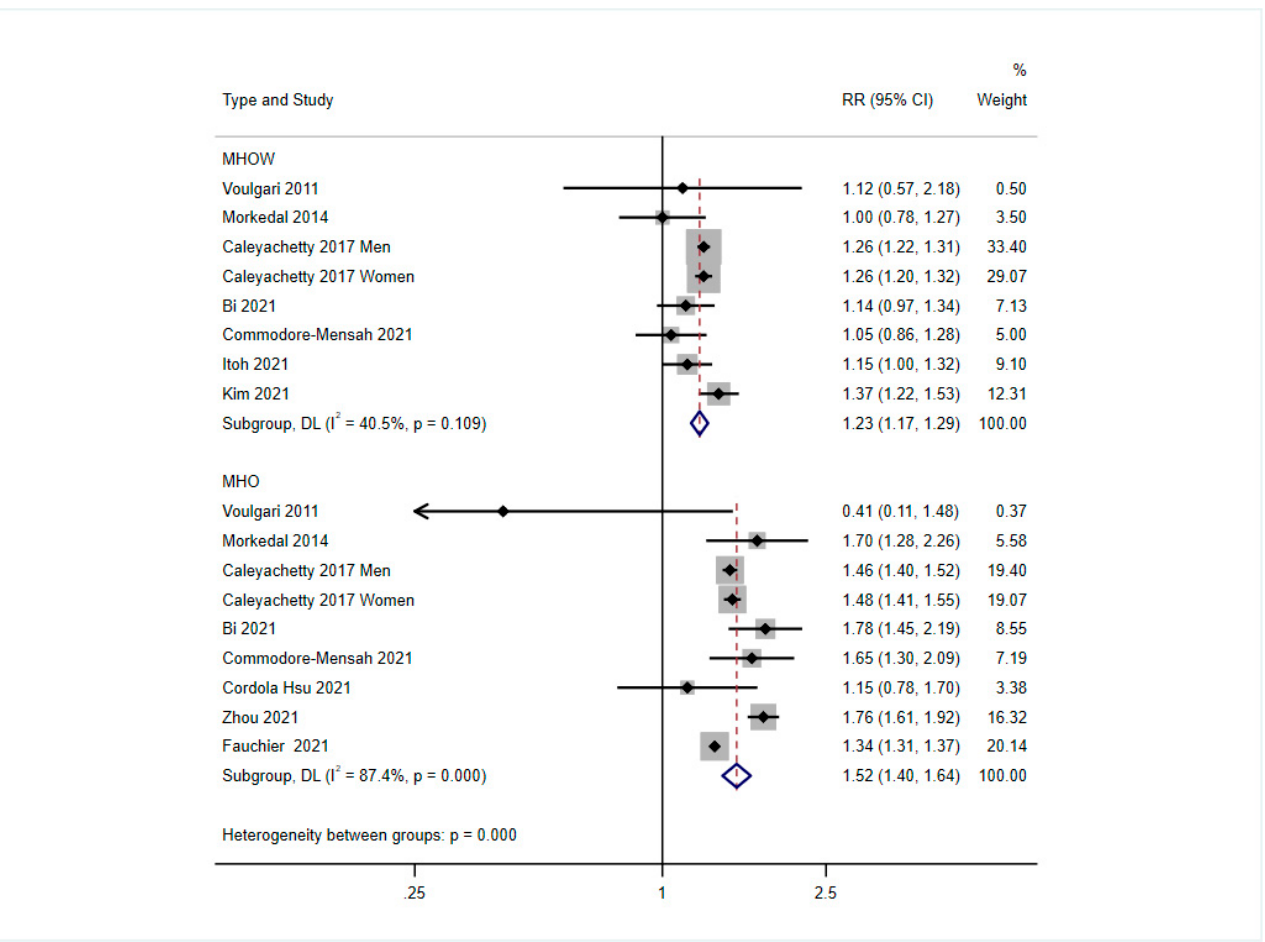
Figure 2. Pooled results of the comparison of the risk of heart failure associated with metabolically healthy overweight or obesity, compared with that of the metabolically healthy normal-weight group. MHOW: Metabolically healthy overweight group, MHO: Metabolically healthy obesity group [14–16,18–20,22,23,30,31].